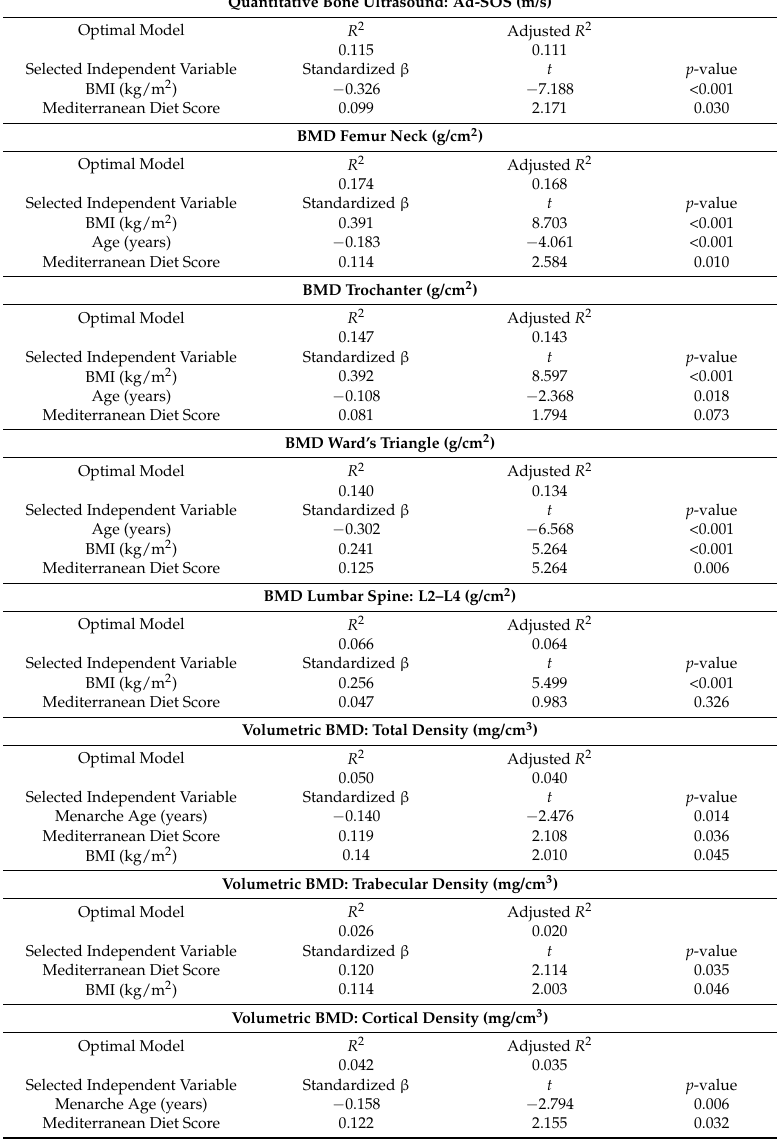
Table 3. Multiple linear regression analysis for the association between bone density and age (years), menarche age (years), BMI (kg/m 2 ), calcium intake (mg/day), vitamin D intake ( µ g/day), energy intake (kcal/day), physical activity, smoking, and Mediterranean diet